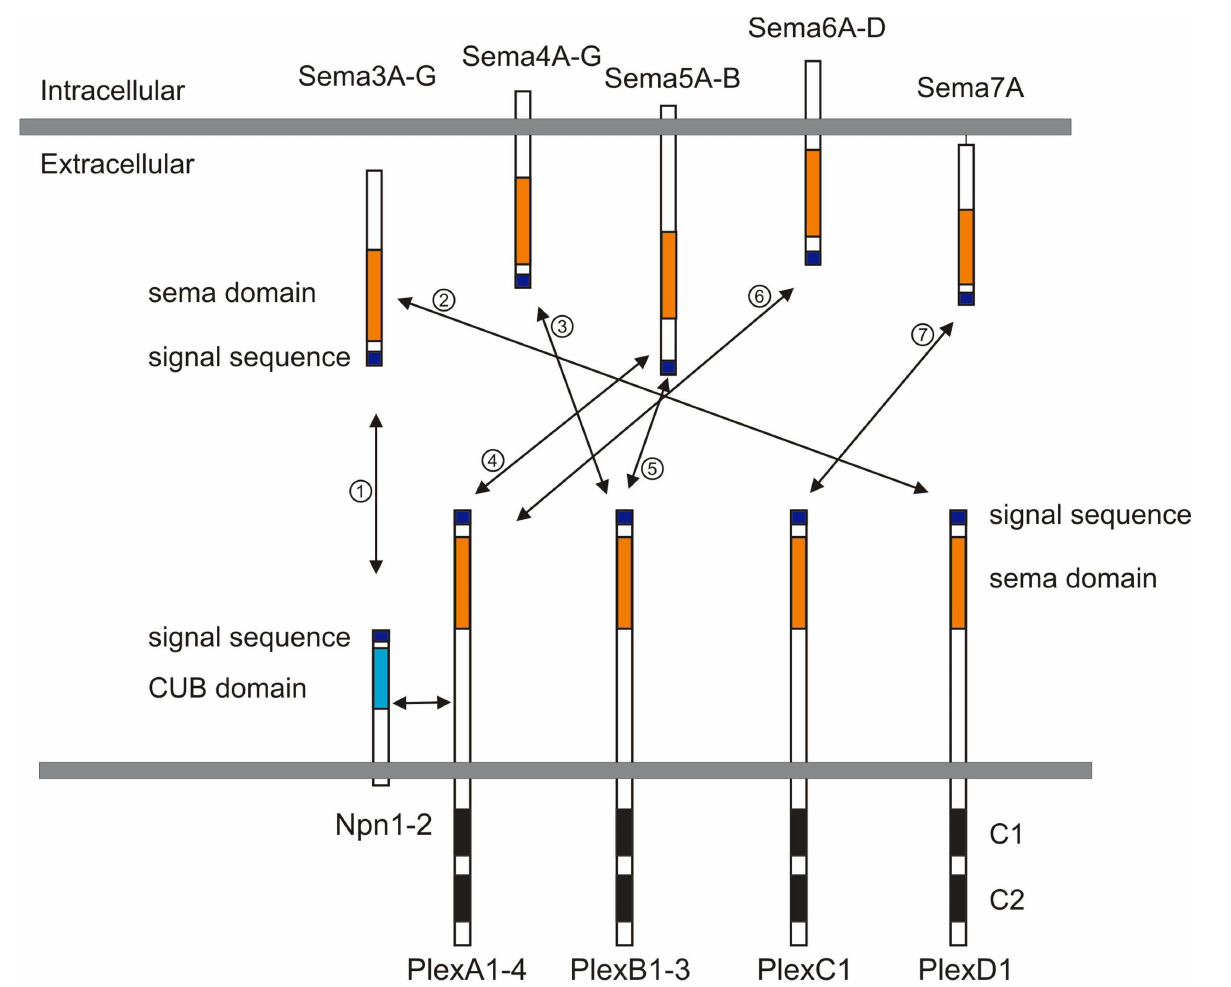
plexinBs. Class 6 semaphorins interact with plexinAs. Sema7A interacts with PlexC1. CUB indicates complement binding. One to seven indicate the interactions between semaphorins and their receptors; 1: class 3 semaphorins and neuropilin1/2, 2: Sema3E and PlexD1, 3: Sema4D and PlexB1/B2 or Sema4C/4G and PlexB1, 4: Sema5A/5B and PlexA1/A3, 5: Sema5A and PlexB3, 6: Sema6A/6B and PlexA2/A3 or Sema6C/6D and PlexA1, 7: Sema7A and